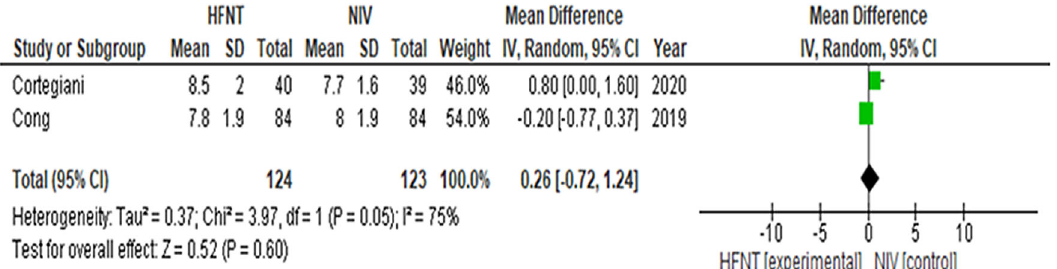
Figure 3. Forest plot of PaCO 2 at last available time-points from Cong et al . 35 and Cortegiani et al . 36